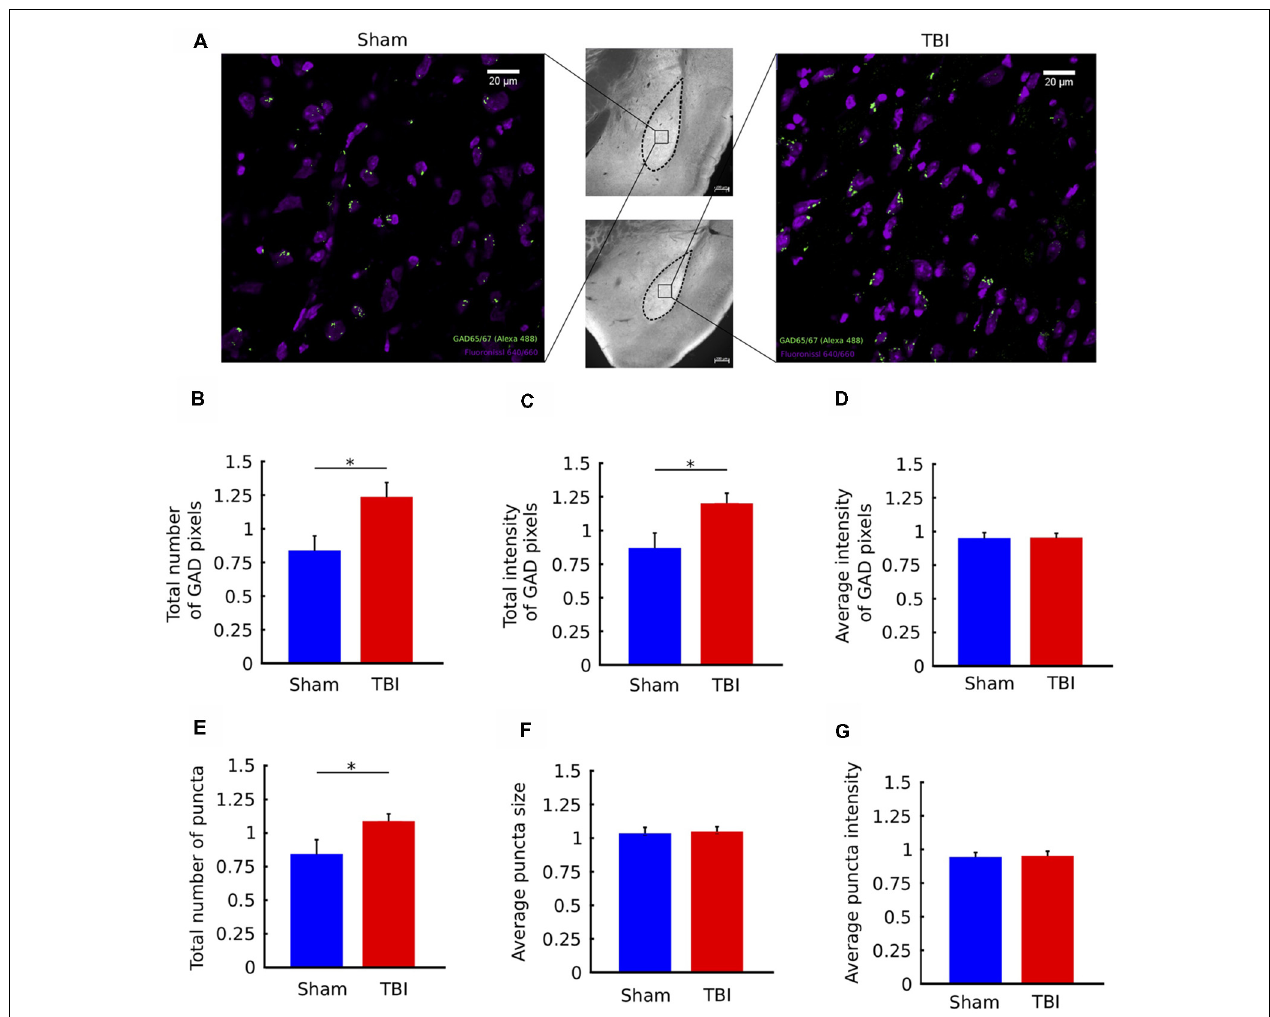
FIGURE 4 | TBI is associated with upregulation of GAD immunostaining in the ipsilateral amygdala. (A) Middle column: 10 × images of histological sections from a sham animal (top) and TBI animal (bottom). Left/Right columns: 63 × views of the indicated portions of the sections. Fluoro Nissl staining in purple and GAD65/67 staining in green. (B–G) Quantification of GAD65/67 expression in the ipsilateral and contralateral BLA in four sections per animal. Metrics in (B–G) are reported as ratios of ipsilateral to contralateral values for each animal. In injured animals, there was a significant increase in the total number of GAD pixels (B) and the total intensity of GAD pixels (C) , but not the average intensity of GAD pixels (D) . In addition, there was an increase in the total number of GAD “puncta” (clusters of contiguous GAD pixels (E) , but not in the average size of puncta (F) or average intensity of puncta (G) . All bar graphs show mean ± SEM of data from n = 10 mice in the TBI condition and n = 10 mice in the sham condition after removal of outliers (“Materials and Methods” section); the number of outliers did not exceed two mice for any; ∗ p < 0.05 (two-tailed t